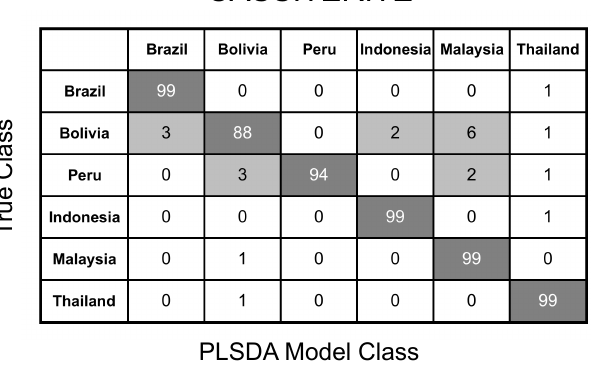
Figure 6. PLSDA classification matrix for LIBS spectral analysis of 38 cassiterite samples from six countries generated using 80 components and 10-fold cross-validation (after Hark and Harmon